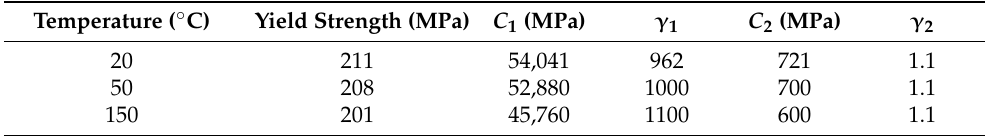
Table 2. Chaboche constitutive model parameters of